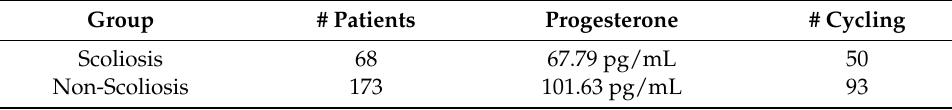
Table 2. Progesterone values based on pre-menopausal patients (currently cycling). Cycling Patients # Patients Progesterone Scoliosis 50 68.42 pg/mL Non-Scoliosis 93 109.75 pg/mL